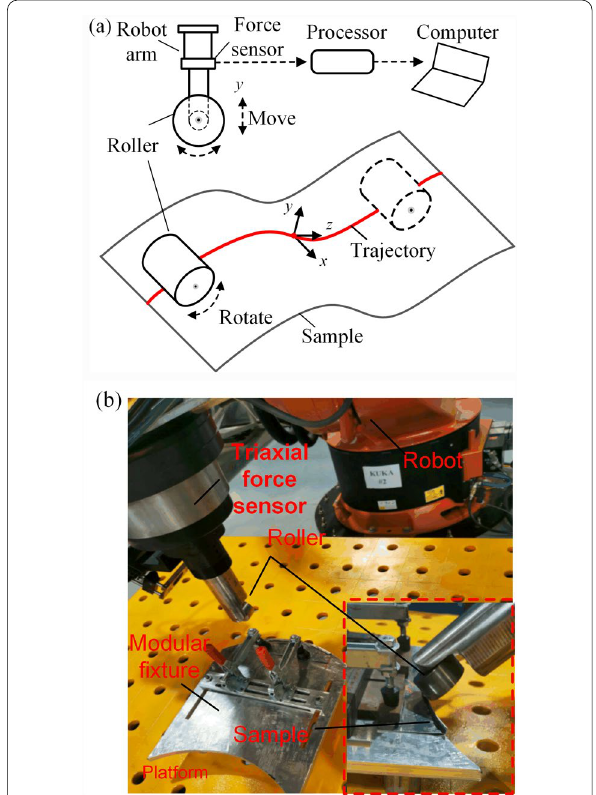
Figure 5 Roller hemming experiment: (a) Schematic diagram of external force monitoring, (b) Experimental